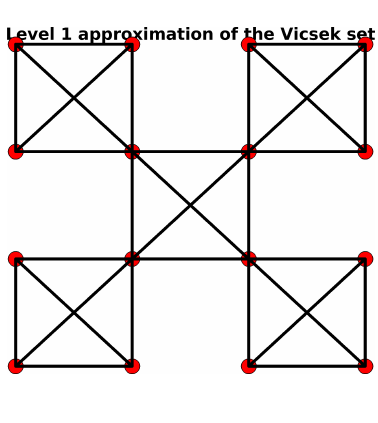
Figure 3: Level 1